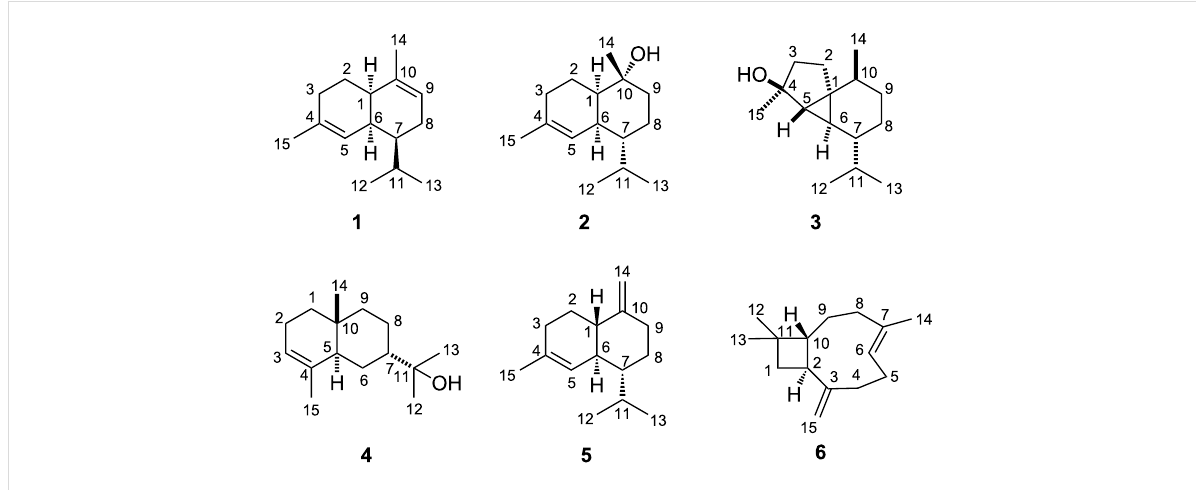
Figure 1: Structures of sesquiterpenes obtained by incubation of FPP with bacterial sesquiterpene cyclases.